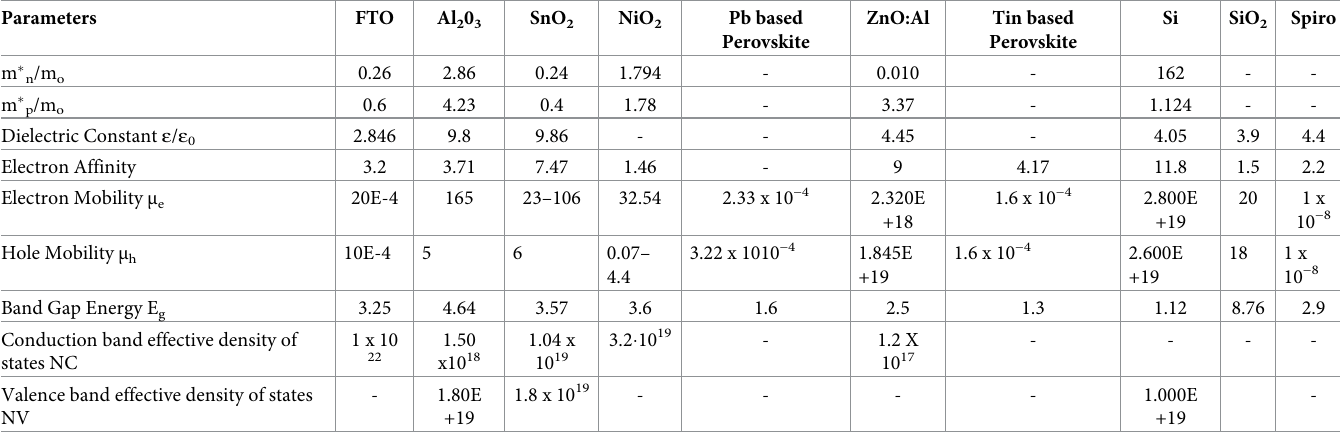
Table 1. Simulated input